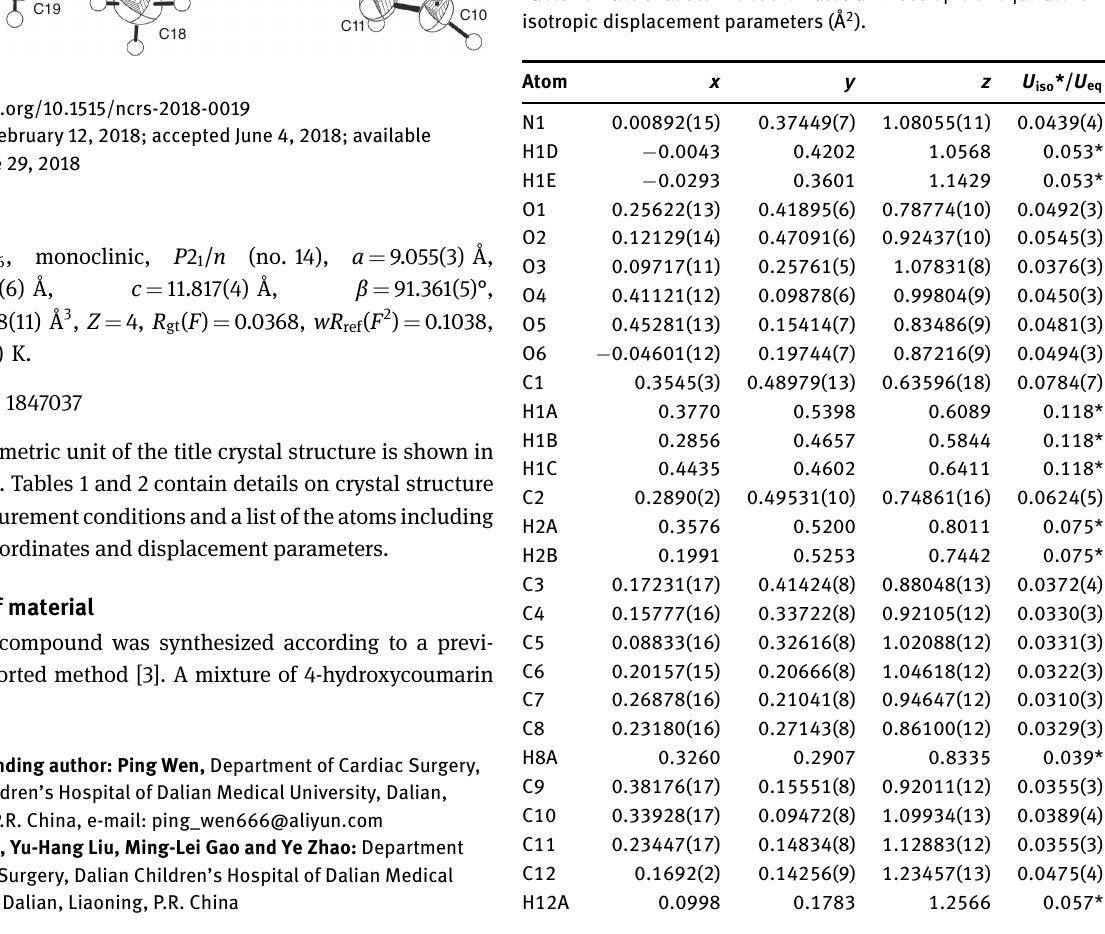
Table 2: Fractional atomic coordinates and isotropic or